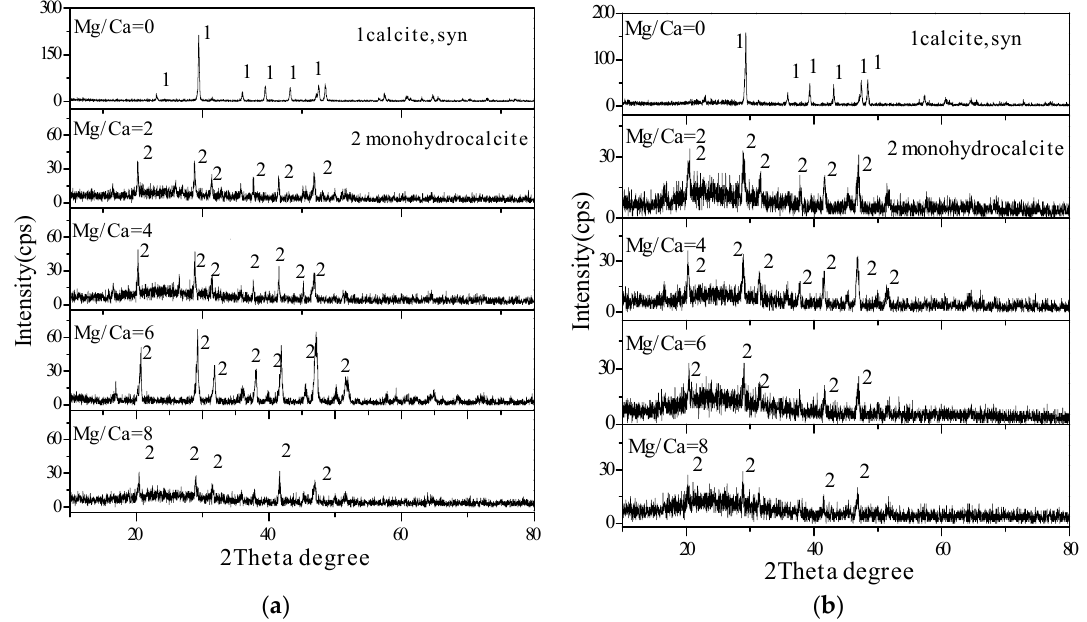
Figure 5. X-ray powder diffraction (XRD) images of minerals in the experimental groups. ( a ) the minerals in the MgSO 4 medium; ( b ) the minerals in the MgCl 2 group.